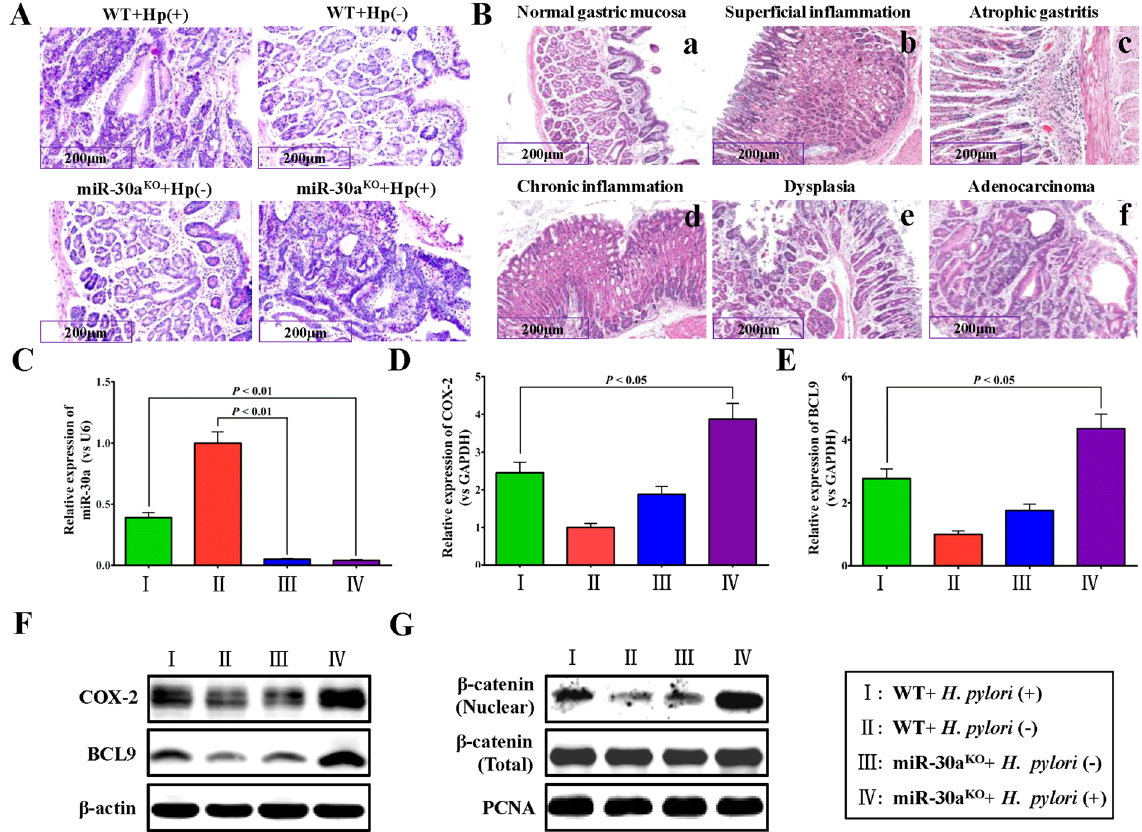
Figure 7. Expression of miR-30a, COX-2, BCL9, β -catenin, VEGF and CD34 in the H. pylori -infected miR-30a knockout mouse model. ( A ) Representative Giemsa staining results of the gastric mucosa from the miR-30a knockout (miR-30a KO ) mice or wild-type (WT) mice infected by H. pylori . miR-30a knockout reduced both the expression levels of miR-30a-3p and miR-30-5p for their complementary stem-loop structure in the presence of miR-30a precursor. ( B ) Representative HE staining results of the gastric mucosa from the miR-30a KO mice (d,e,f) or WT mice (b,c) infected by H. pylori or WT mice without H. pylori infection (a). ( C ) qRT-PCR assay for miR-30a in gastric mucosa from the miR-30a KO mice or WT mice infected by H. pylori , normalized to WT mice without H. pylori infection. ( D , E ) qRT-PCR assay for COX-2 and BCL9 in gastric mucosa from the miR- 30a KO mice or WT mice infected by H. pylori , normalized to WT mice without H. pylori infection Data are shown as mean ± SD; n = 3. ** p < 0.01, was considered as statistically highly significant. ( F , G ) Western blot and quantitative analysis for COX-2, BCL9 and β -catenin in gastric mucosa from the miR-30a KO mice or WT mice infected by H. pylori . PCNA (Nuclear) and β -actin (Total) was used as a loading control.